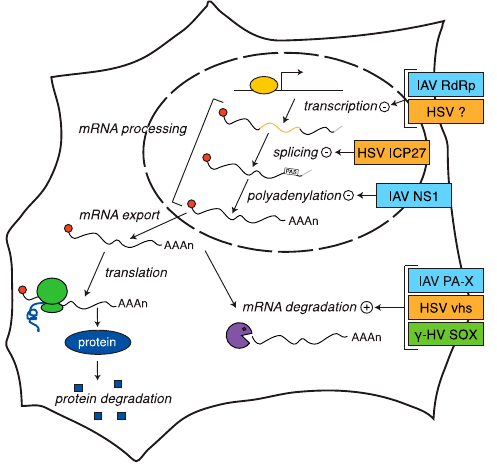
Figure 1. Herpesviruses and influenza A virus use multiple mechanisms to block host gene expression. In eukaryotes, production of proteins requires transcription, processing, nuclear export, and translation of mRNAs. The α -herpesvirus herpes simplex viruses (HSV), the γ -herpesviruses, and influenza A virus (IAV) use multiple viral factors to negatively regulate different stages of mRNA biogenesis and reduce host gene expression. They also stimulate host mRNA degradation.